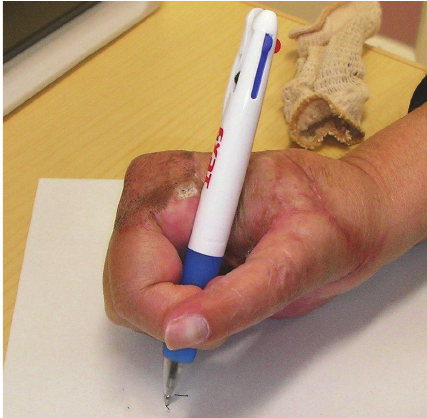
Figure 4: Postoperative appearance of the right hand. The patient used the pollicized thumb for activities of daily living, such as